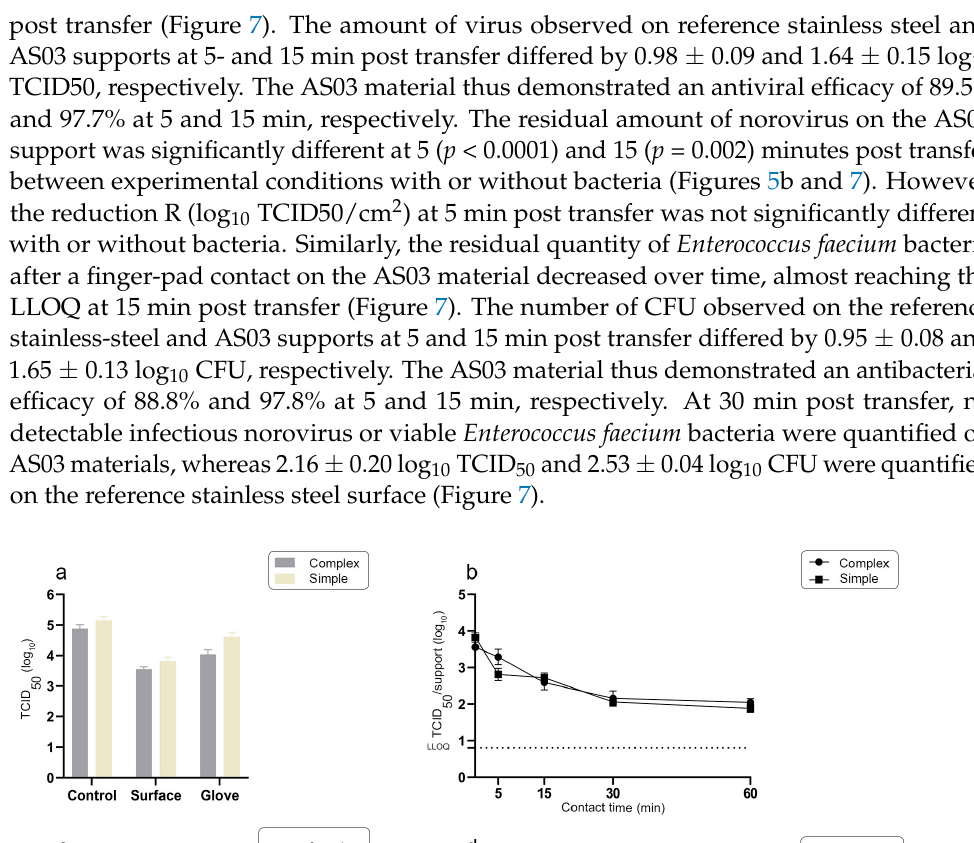
Figure 6. ( a ): Amount of infectious murine norovirus on stainless steel supports (surface) at T0, following transfer from a gloved fingertip artificially contaminated with the virus alone (simple) or with the complex mixture (complex); residual quantities of virus on gloved fingertip after the viral transfer (glove) and from direct washing of fingertips prior to transferring to the surface (control). Mean values ± SD corresponding to 10 independent viral transfers. ( b ): Survival of murine norovirus on stainless steel supports after viral transfer (simple) or mixture transfer (complex). LLOQ: lower limit of quantification (=0.8 log 10 TCID 50 ). Mean values ± SD corresponding to 10 inoculated supports for each time point. ( c ): Amount of Enterococcus faecium bacteria at T0 on stainless steel supports (surface) transferred from gloved fingertip artificially contaminated with complex mixture; residual quantities of bacteria on gloved fingertip after the transfer (glove) and from the direct washing of fingertips prior to transferring to the surface (control). Mean values ± SD corresponding to 10 independent experimental transfers. ( d ): Survival of Enterococcus faecium bacteria on stainless steel supports after mixture transfer (complex). LLOQ: lower limit of quantification (=1.1 log 10 CFU corresponding to 14 colonies). Mean values ± SD corresponding to 10 inoculated supports for each time point.